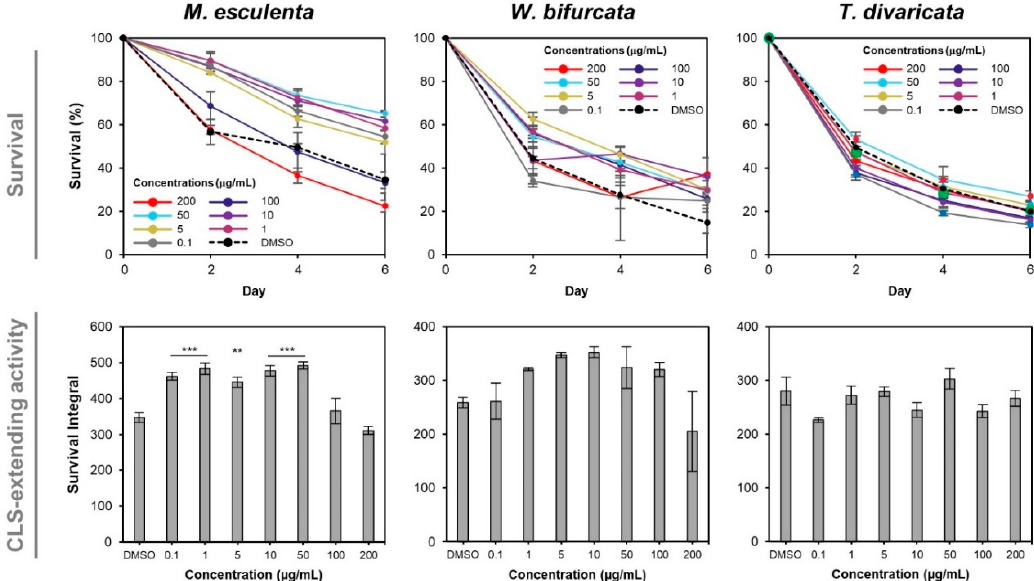
Figure 2. Dose-dependent effects of M. esculenta , W. bifurcata and T. divaricata extracts on yeast CLS. Yeast cells of strain 1783 treated with different concentrations of M. esculenta , W. bifurcata or T. divaricata leaf extract, or DMSO control were chronologically aged in Bijou bottles containing SC media until day 6. An aliquot of each aged culture was transferred to a 96-well microplate containing YPD medium for outgrowth on day 0, 2, 4 and 6. The survival percentages and survival integrals of the cultures were derived from the outgrowth curves (Supplementary Figure S11). Tukey test was performed (IBM SPSS Statistics software). The survival integrals of yeast cells treated with M. esculenta only at 0.1, 1, 5, 10, 50 µ g/mL were significantly different from that of the DMSO control cells (** p < 0.01; *** p < 0.001). Error bars represent the SEM of three biological